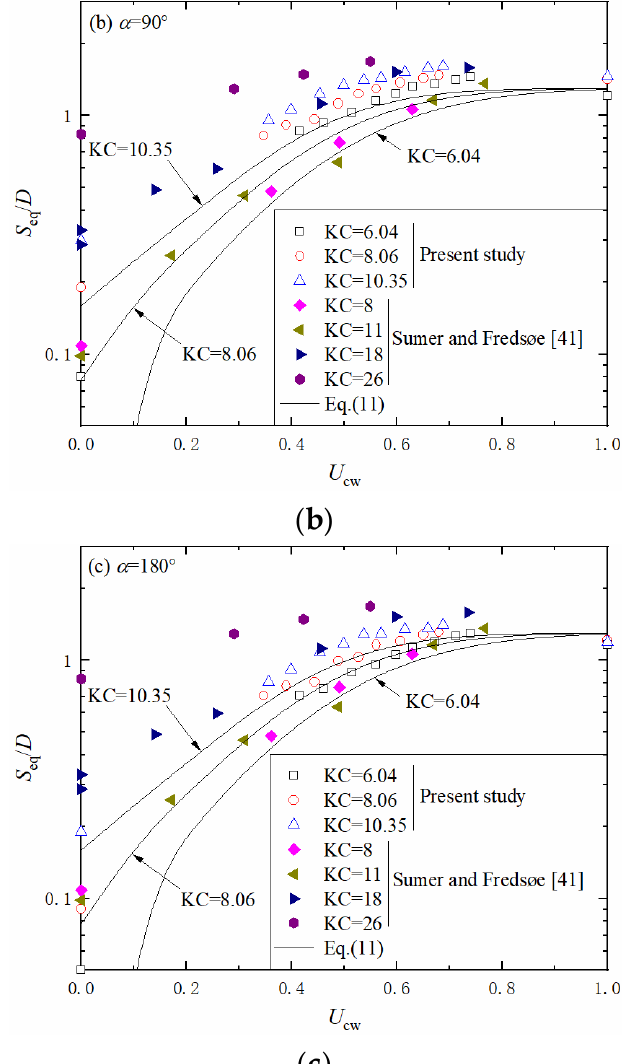
Figure 7. The relationships of S eq and U cw under different ranges of KC for: ( a ) α = 0°; ( b ) α = 90°; ( c ) α = 180°.